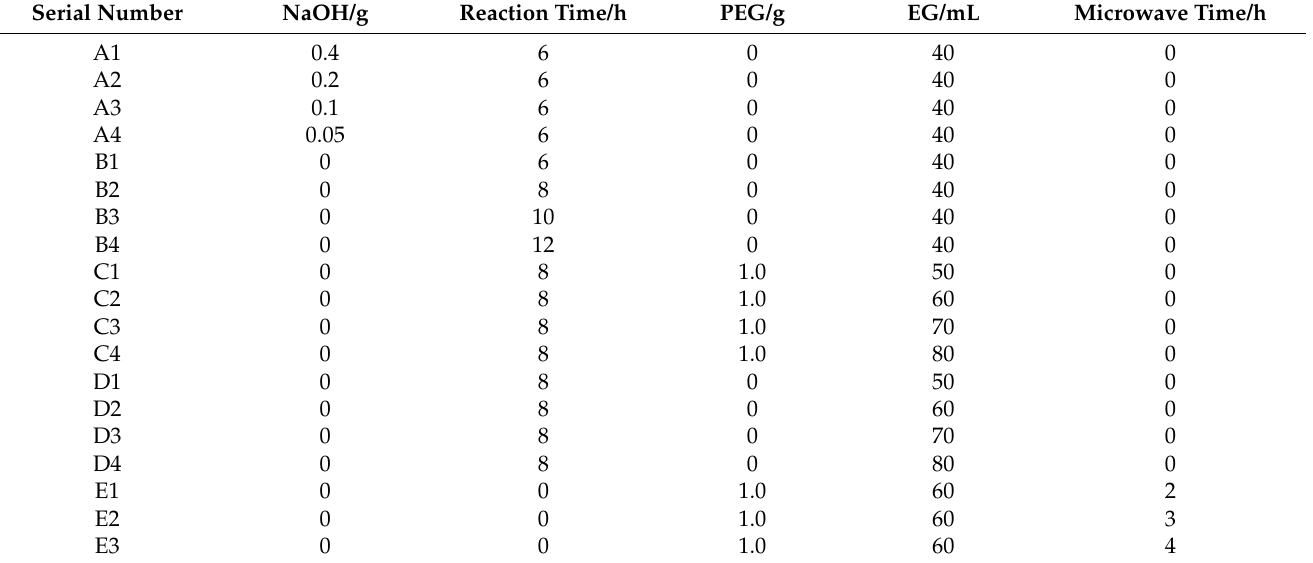
Table 1. Experimental design